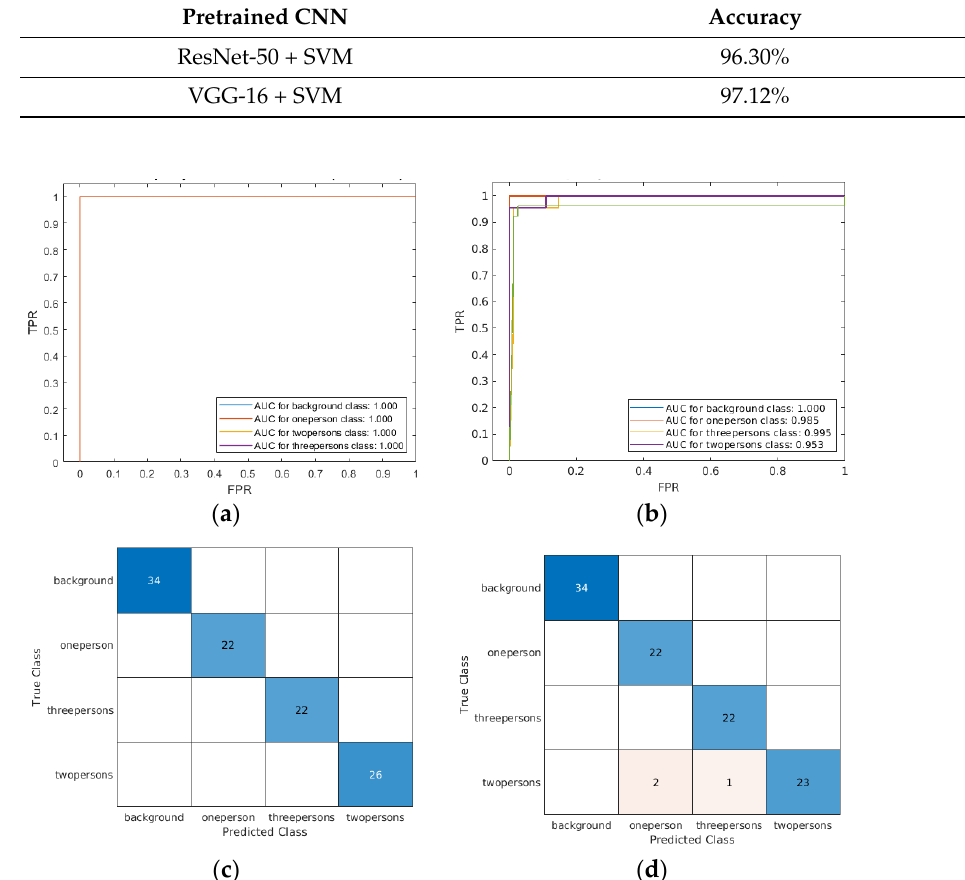
Figure 8. ROC curves and confusion matrices for testing set ( a ) wavelet scattering + multi classification SVM ( b ) VGG-16 + multi classification SVM ( c ) confusion matrix for wavelet scattering + multi classification SVM and ( d ) VGG-16 deep features + SVM.